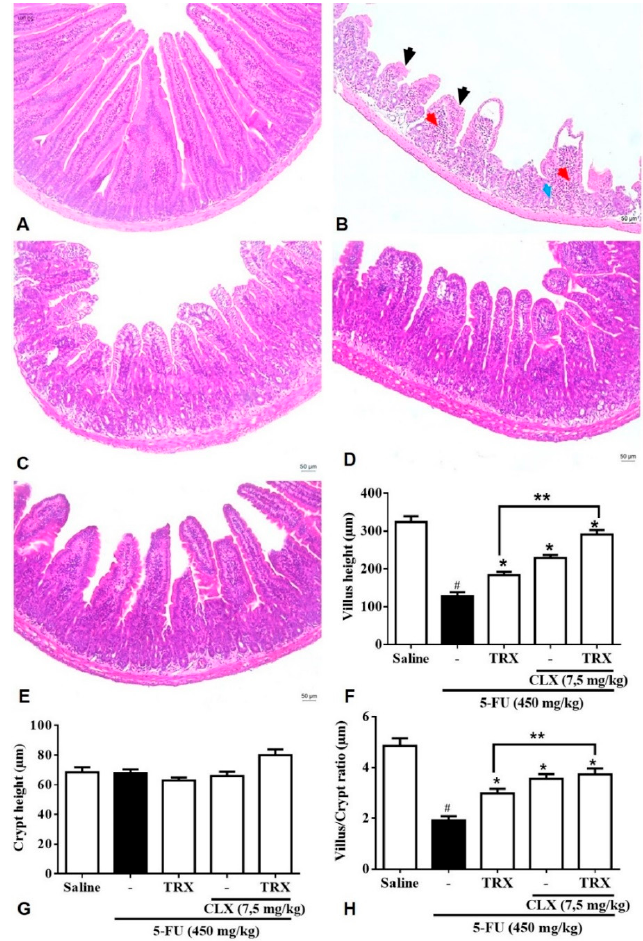
Figure 7. E ff ect of TRX under cyclooxygenase-2 pathway (COX-2) evaluated by histopathological and morphometric analysis in segments of the duodenum. The tissues were submitted to H&E staining for morphometric and histopathological analysis after incubation with celecoxib. Salina ( A ); 5-FU ( B ); TRX-100 ( C ); CLX ( D ); TRX and CLX ( E ); height of villi ( F ); depth of the crypts ( G ); villus / crypt ratio ( H ). The histopathological issues are indicated by arrows. Inflammatory cells infiltration (red arrow), decreasing of intestinal villi (black arrow) and loss of intestinal crypt architecture (blue arrow). Values were expressed as mean ± SEM. For statistical analysis, one-way ANOVA followed by the Tukey test was used, where p < 0.05 vs. saline group, * p < 0.05 vs. 5-FU group, ** p < 0.05 vs. TRX group.